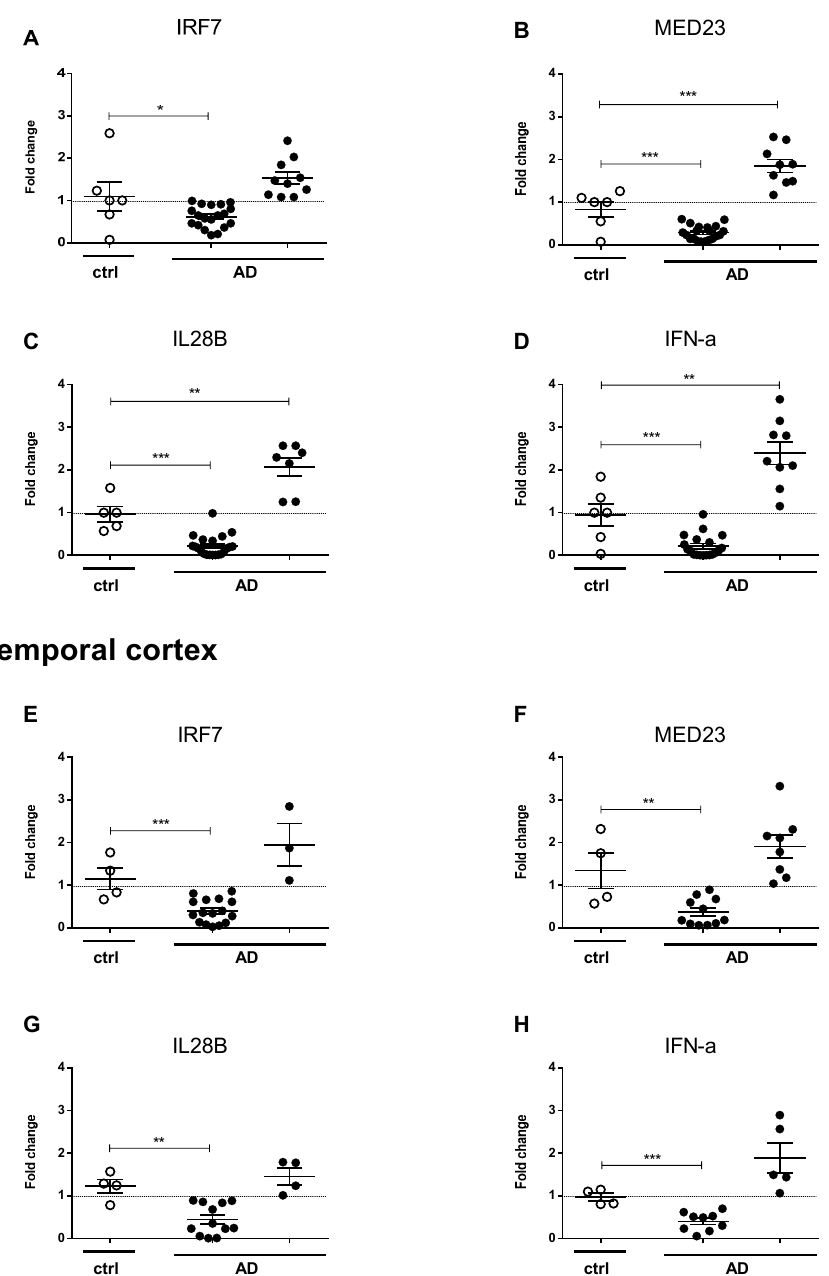
Figure 1. Hippocampal and temporal cortex differential expression of antiviral response genes in Alzheimer’s disease (AD) patients and control subjects. Fold change (q-PCR 2 - ∆∆ Ct method) of IRF7 ( A , E ), MED23 ( B , F ), IL28B ( C , G ), IFN- α ( D , H ) normalized to two reference genes (CYC1 and EIF4A2) and relative to control healthy subjects (ctrl), in hippocampus ( A – D ) and temporal cortex ( E – H ) of patients with clinical and neurological defined diagnosis of AD. Values are given as fold change ± SEM. * p < 0.05; ** p < 0.01; *** p < 0.001 (unpaired t